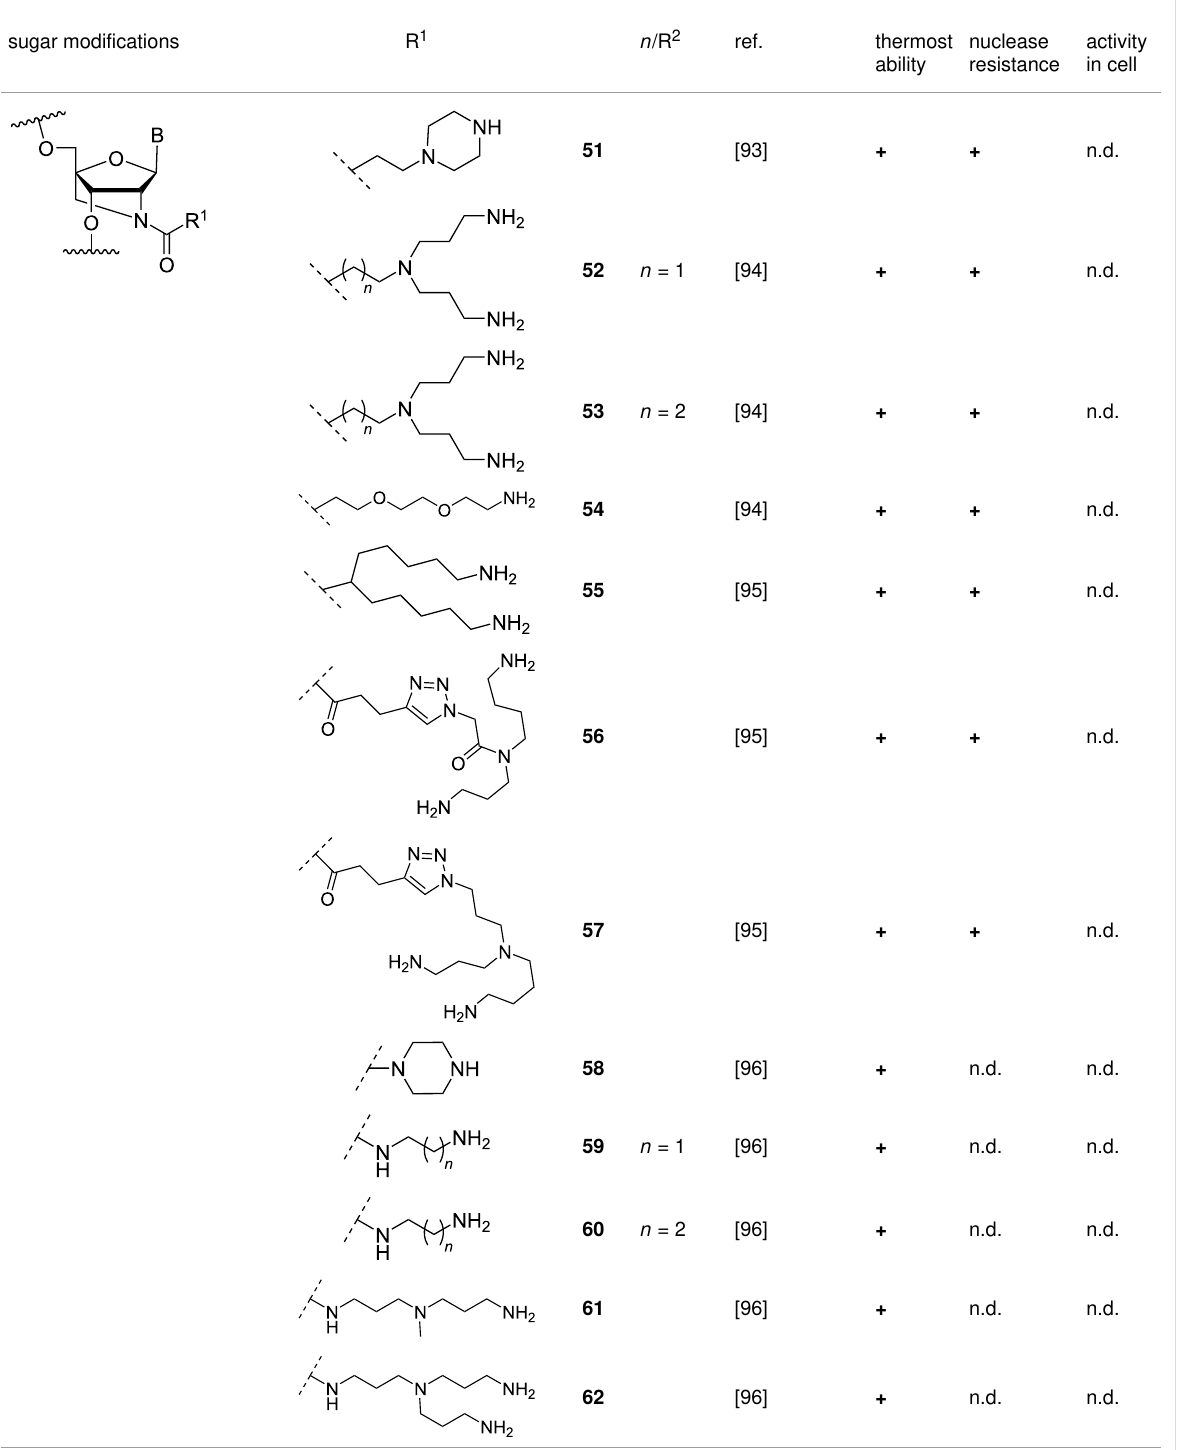
Table 6: Amine-functionalized groups attached to the sugar scaffold.